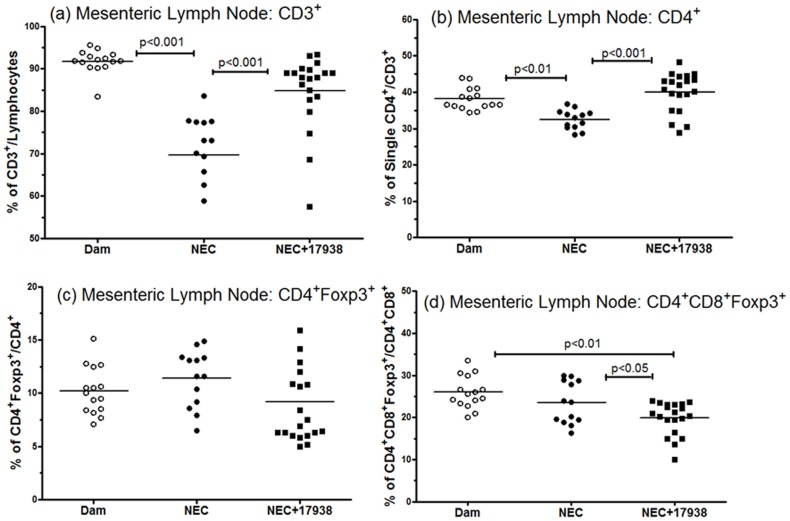
Effect of Lactobacillus reuteriDSM 17938 on CD3+, CD4+ and Foxp3+ T cells in the mesenteric lymph nodes of rats with NEC.(a): changes of CD3+ T cells of lymphocytes, (b) % of CD4+ T cells/CD3+ T cells, (c) % of CD4+Foxp3+, and (d) double positive CD4+CD8+Foxp3+ cells in the mesenteric lymph nodes in different groups. The numbers represent percent of T cells (mean ± SE). Each dot represents one animal in each group in the figures. Dam-fed: N = 15, NEC: N = 13, NEC+17938: N = 20.